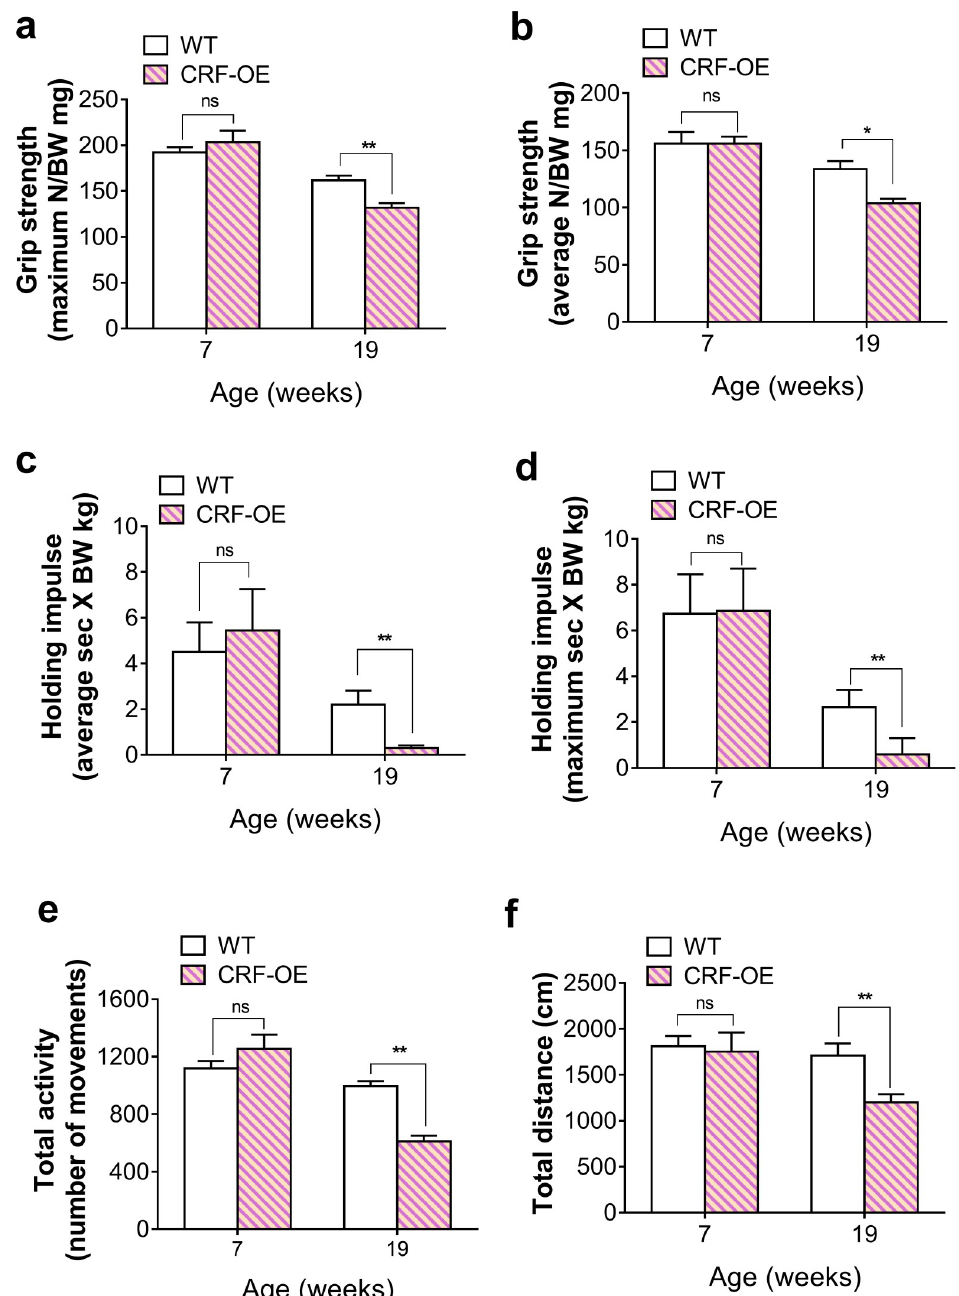
Fig 2. CRF-OE mice displayed muscle weakness. (a and b) Four-limb grip strength and (c and d) wire hanging fall latency normalized to body weight. (e) Number of movements. (f) Total distance travelled. � P < 0.05 and �� P < 0.01 compared to WT mice. Values represent the mean ± s.e.m (n =